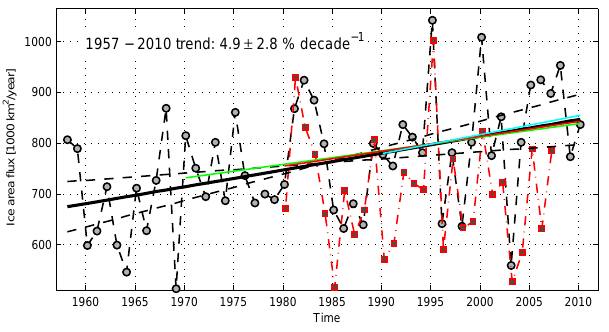
Fig. 8. Annual mean Fram Strait sea ice area export values as driven by NCEP surface pressure difference. Values are averages for 1 September. through 31 August. Dashed lines indicate the 95% confidence interval of the trend. Linear trends are added on- wards from 1970, 1980 and 1990 (different colours). Values from Kwok (2009) are added for comparison (red dash-dotted